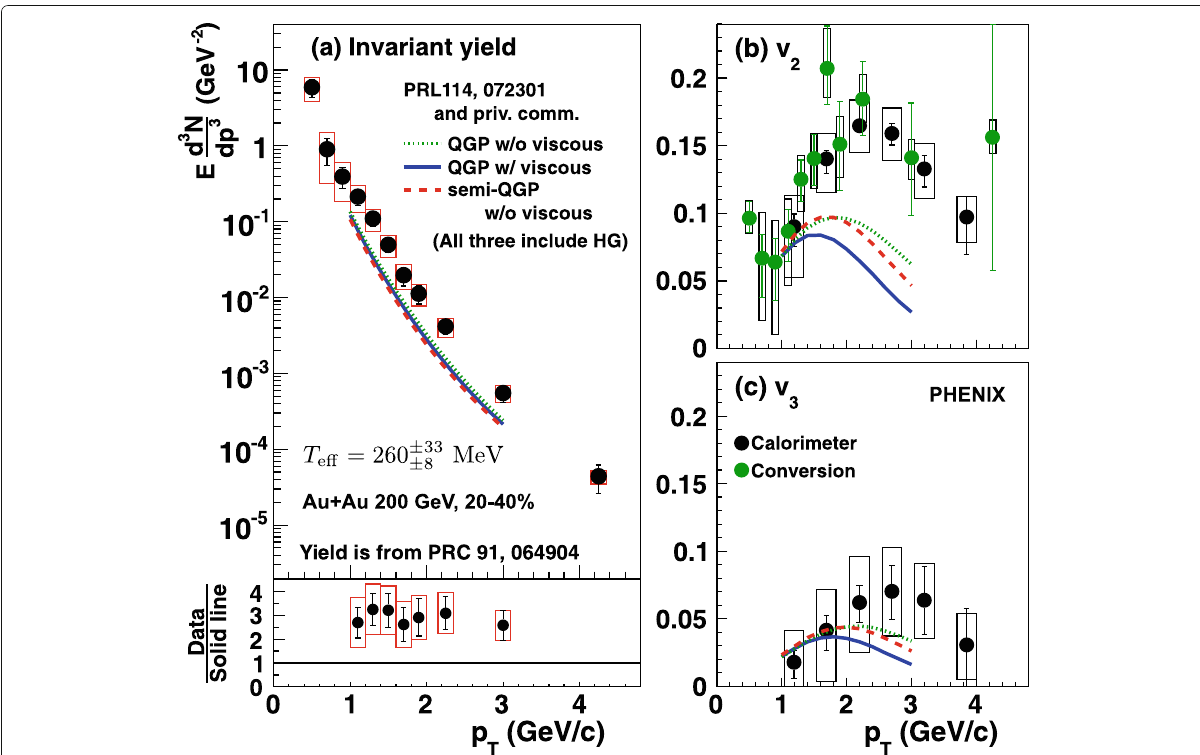
Fig. 10 Direct photon yield ( a ), elliptic ( b ), and triangular ( c ) flow as a function of the transverse momentum [58] comparing to hydrodynamic model calculations with different assumptions. An effective temperature T eff extracted from the inverse slope of the yield is shown in the figure. See Ref. [58] and references therein for details